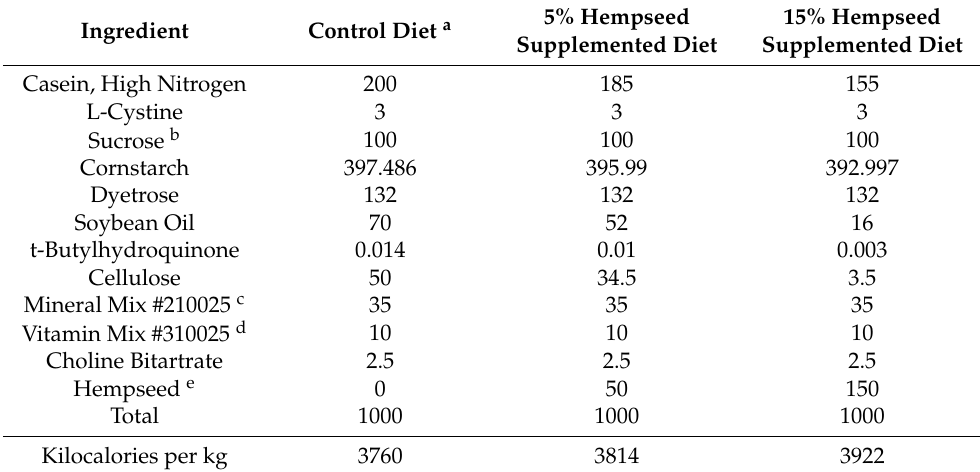
Table 1. Experimental diet ingredients